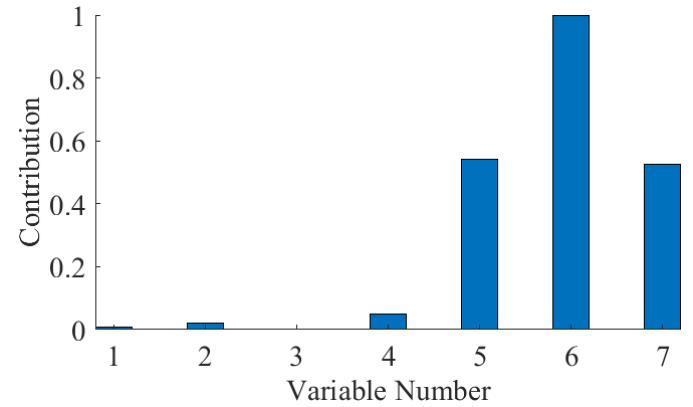
Figure 9. The fault contribution rate for each variable in Case